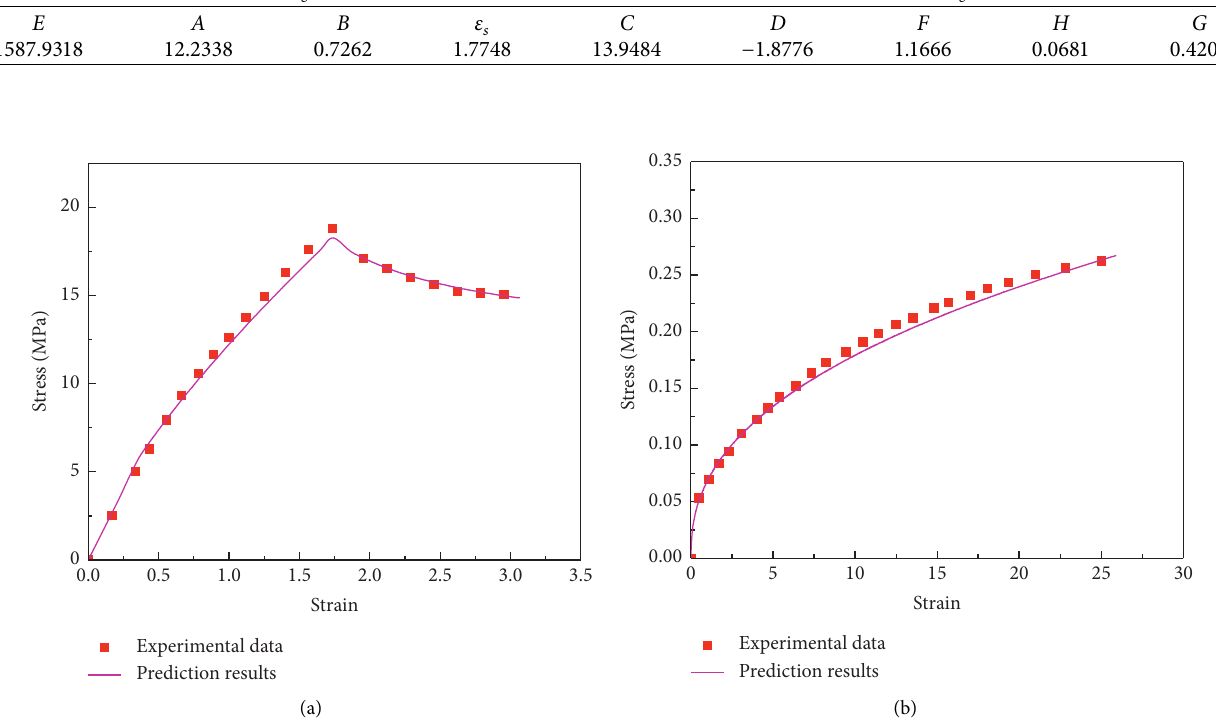
Figure 10: Comparison of experimental data and prediction results at different temperature. (a) 348K and (b)